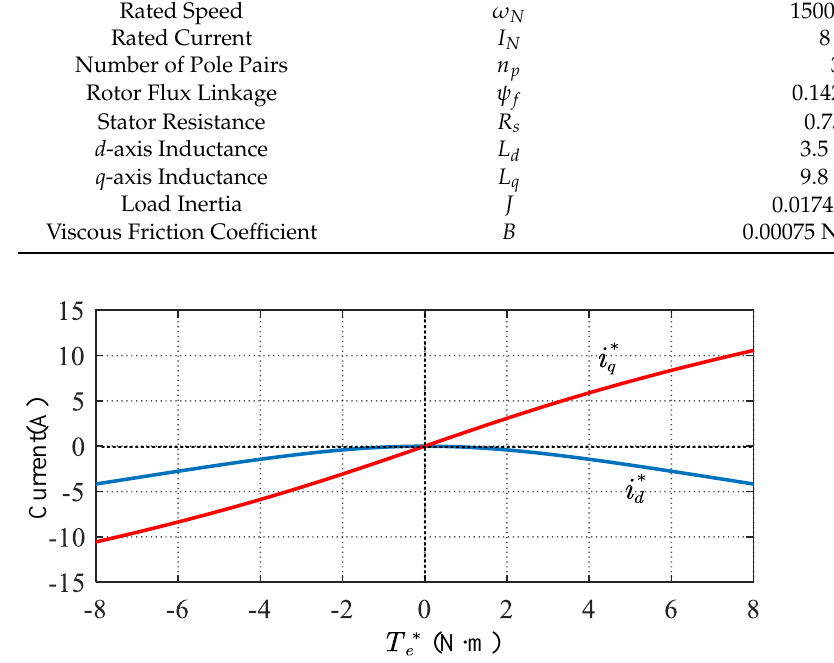
Figure 12. Relationship between T ∗ e and i ∗